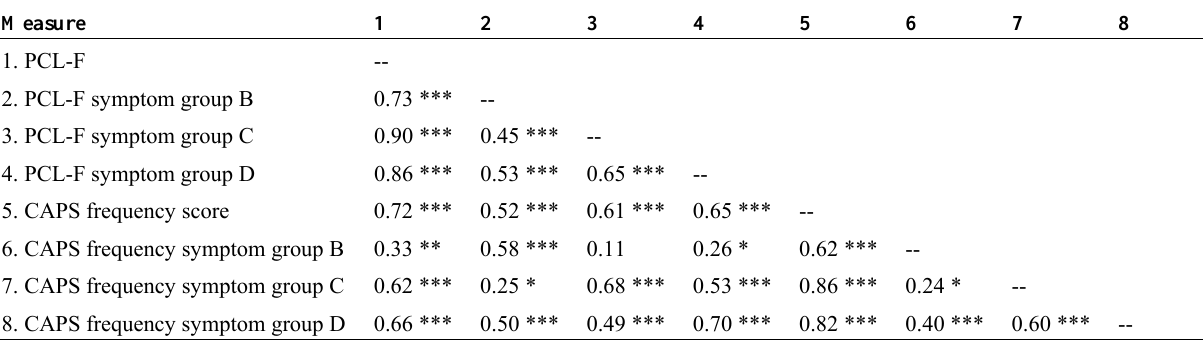
Table 3. Correlation matrix of PCL-F and CAPS frequency scores.